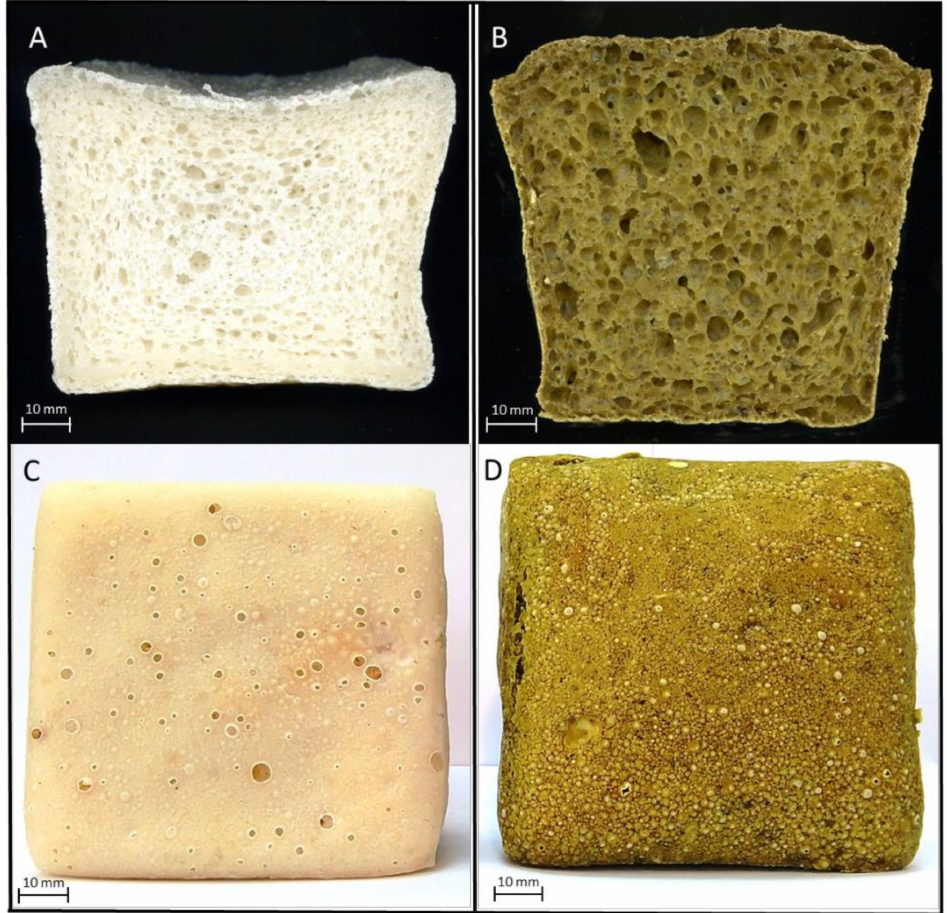
Figure 1. The visual appearance of crumb and crust of exemplary control gluten-free bread ( A , C ) and gluten-free bread with broccoli leaves powder ( B , D